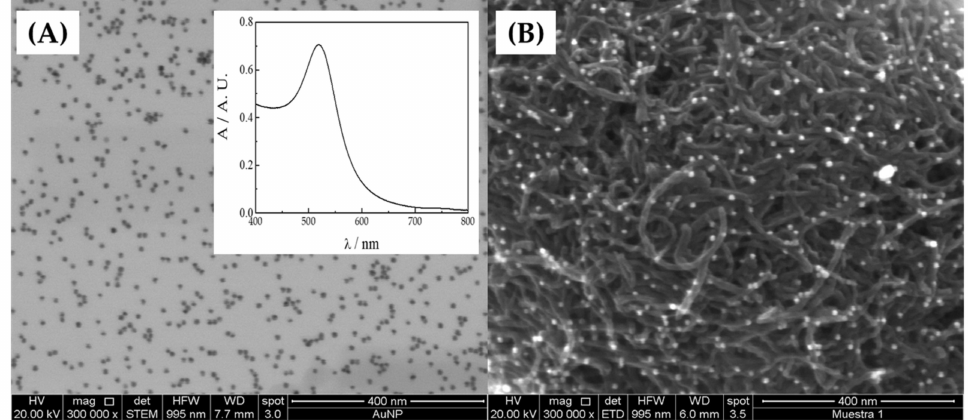
Figure 3. ( A ) Transmission Electron Microscopy (TEM) and AuNP characterization, (Inset) VIS-NIR spectroscopy made for AuNP solution. Experimental conditions: Zeta potential: − 20.3 mV. ( B ) Scanning Electron Microscopy (SEM) made to GCE/MWCNT-NH 2